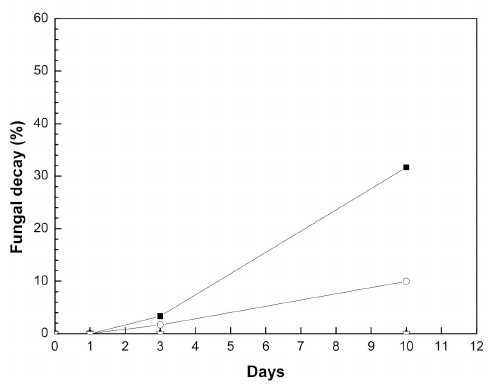
Figure 6. Fungal decay of uncoated and licorice-chitosan-coated strawberries stored for 10 days at 4 ◦ C: ( ) Ch (Chitosan); ( (cid:4) ) C (cid:35)